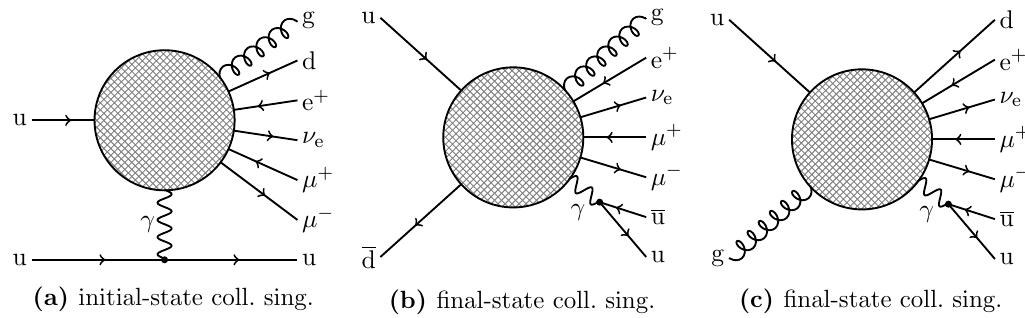
Figure 4. Photon singularities in the